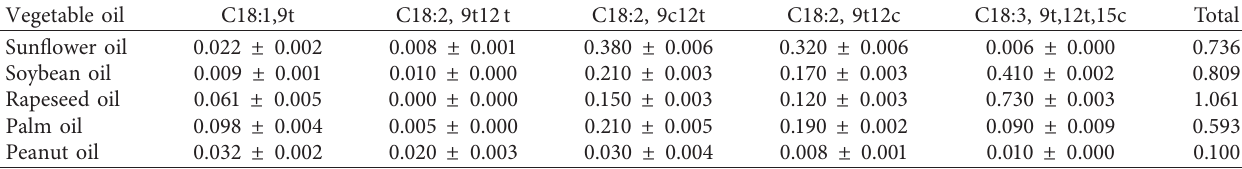
Table 1: Types and levels of trans fatty acids in youtiao prepared using five types of vegetable oils (mg/g). Vegetable